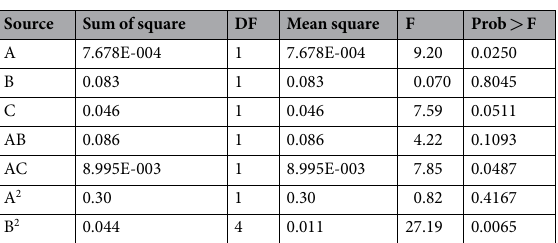
Table 2. ANOVA for CY surface modified model.